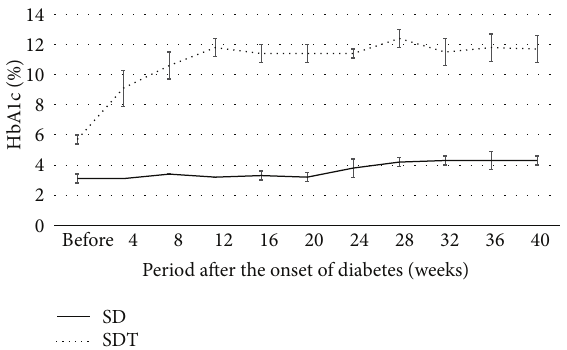
Figure 4: The relationship between the retinal and choroidal thicknesses in the SDT rats. 𝑟 𝑠 = 0.81 , 𝑃 < 0.05 .